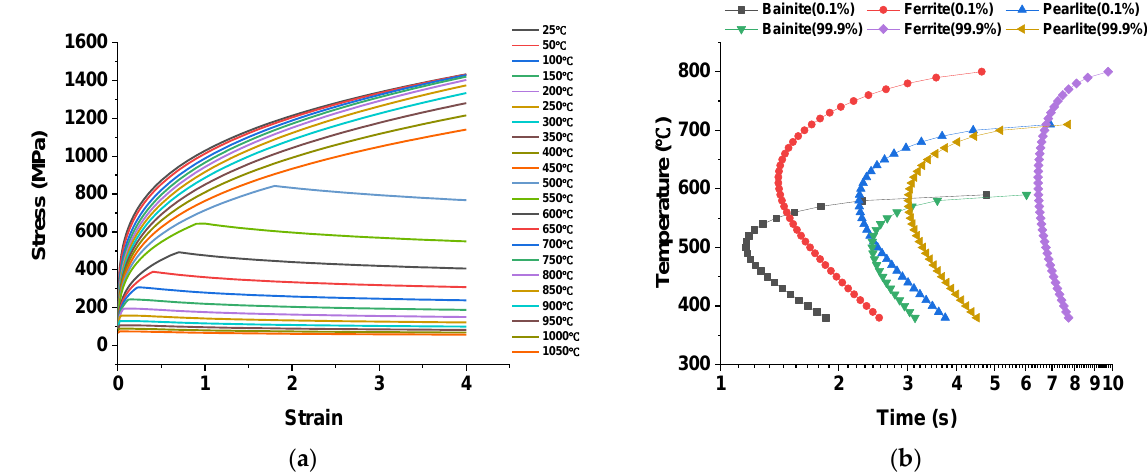
Figure 2. Material properties applied in analysis: ( a ) flow stress (strain rate 0.01/s); ( b ) TTT curve.